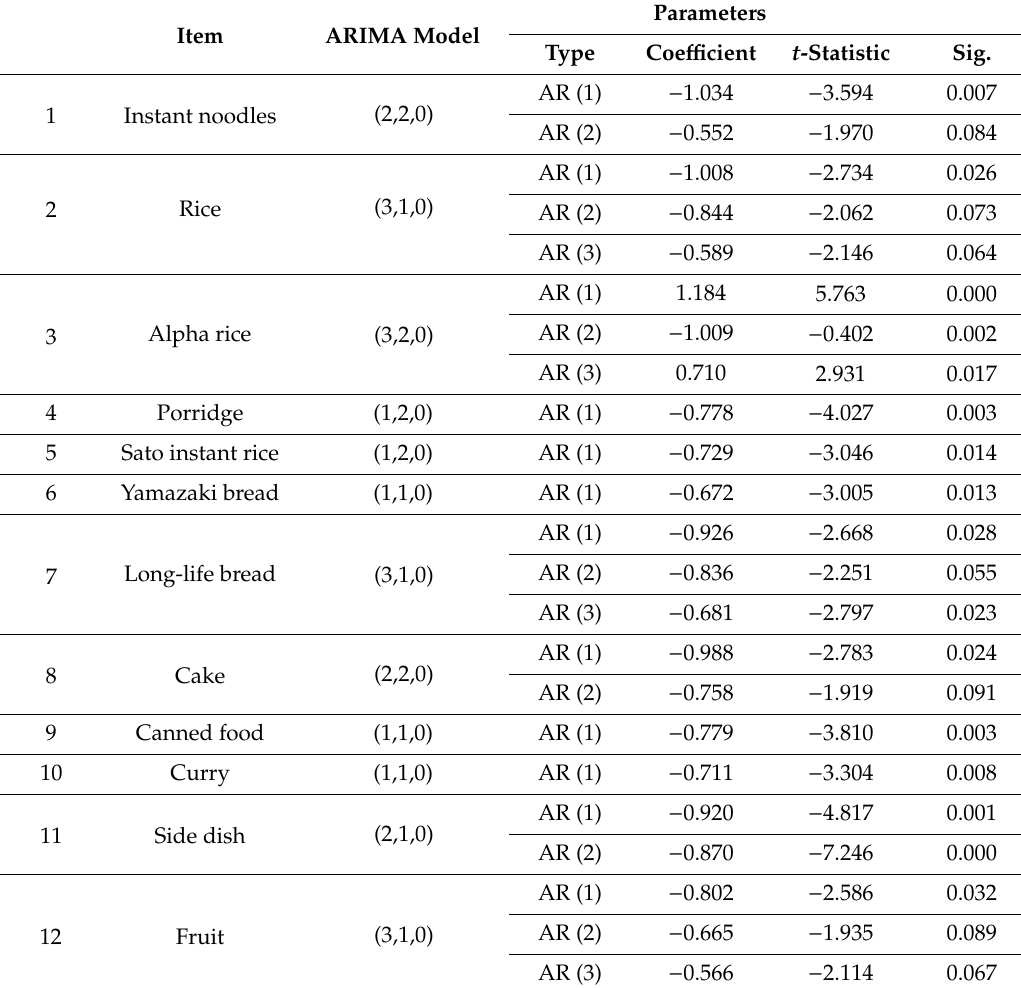
Table 2. Analysis of variance